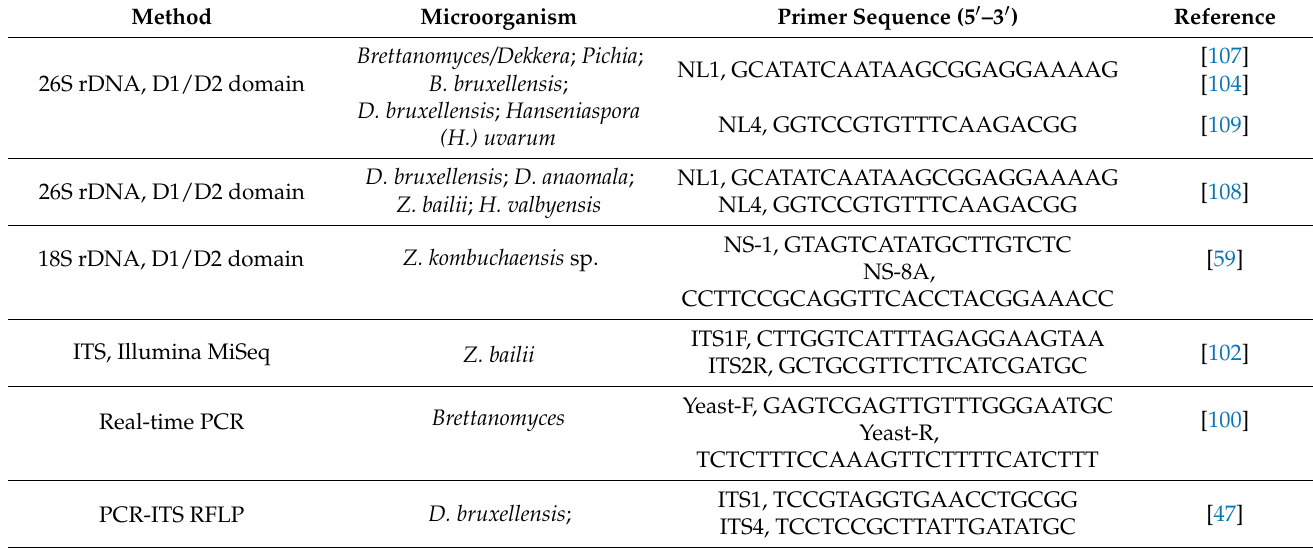
Table 11. Molecular techniques used for the identification of yeast present in